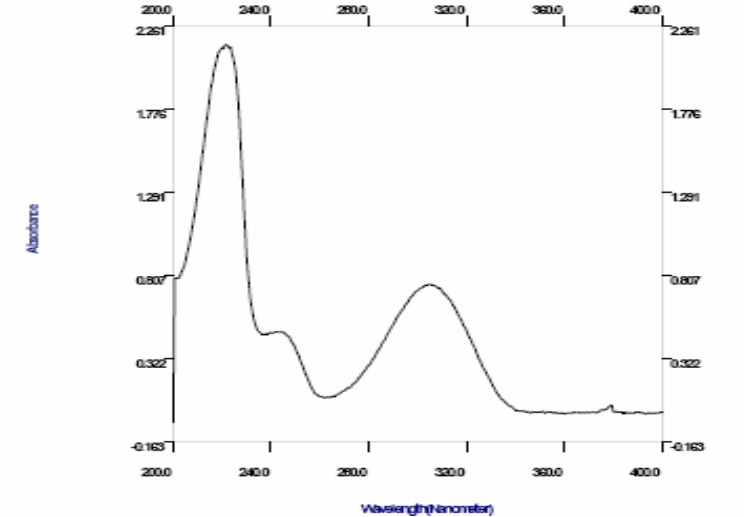
Figure 5. Famciclovir UV Spectrum at 10 µ